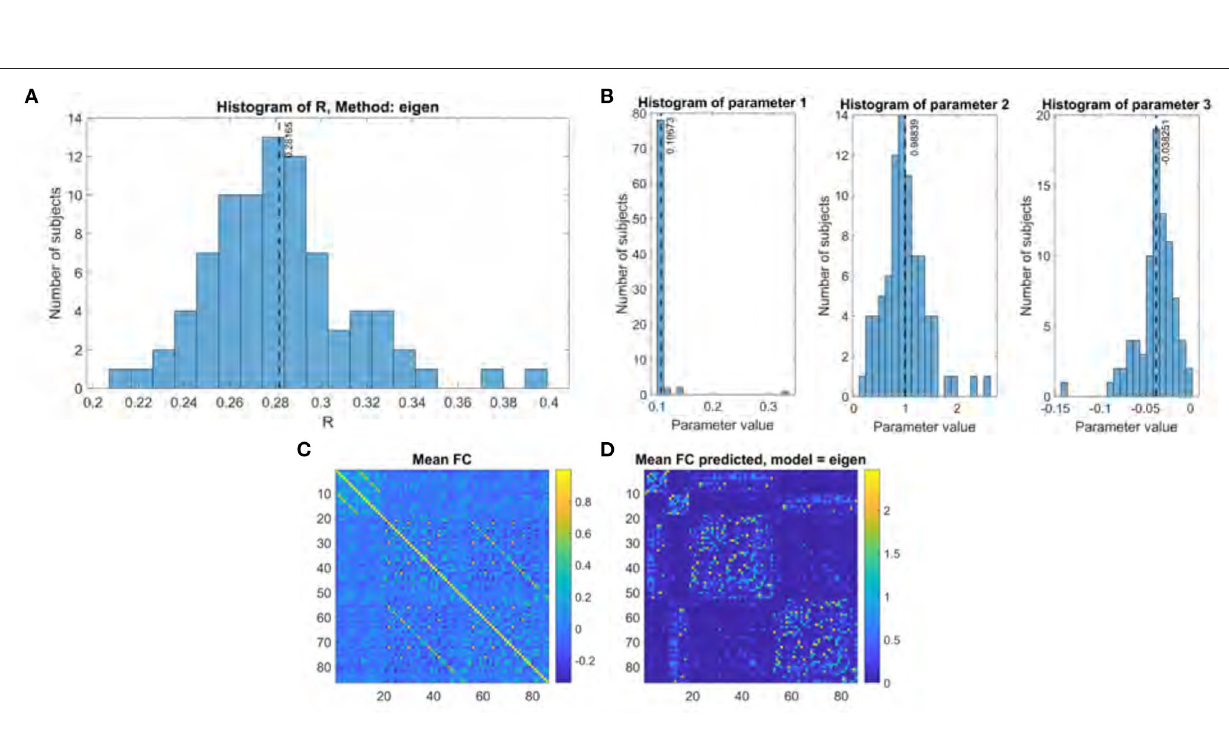
Frontiers in Neuroscience |